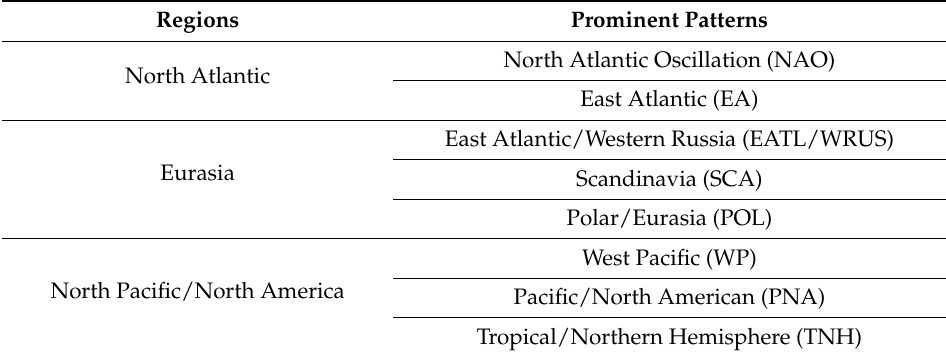
Table 1. Major Atmospheric Teleconnection Patterns in Different Regions of the Northern